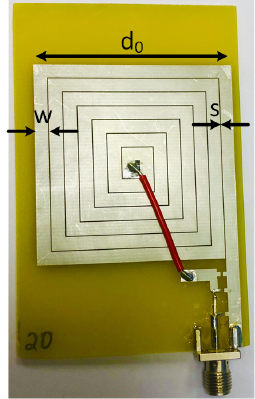
Figure 5. Transmitter (TX) coil fabricated on Cu-clad FR4 substrate. Table 2. Geometrical characteristics of the